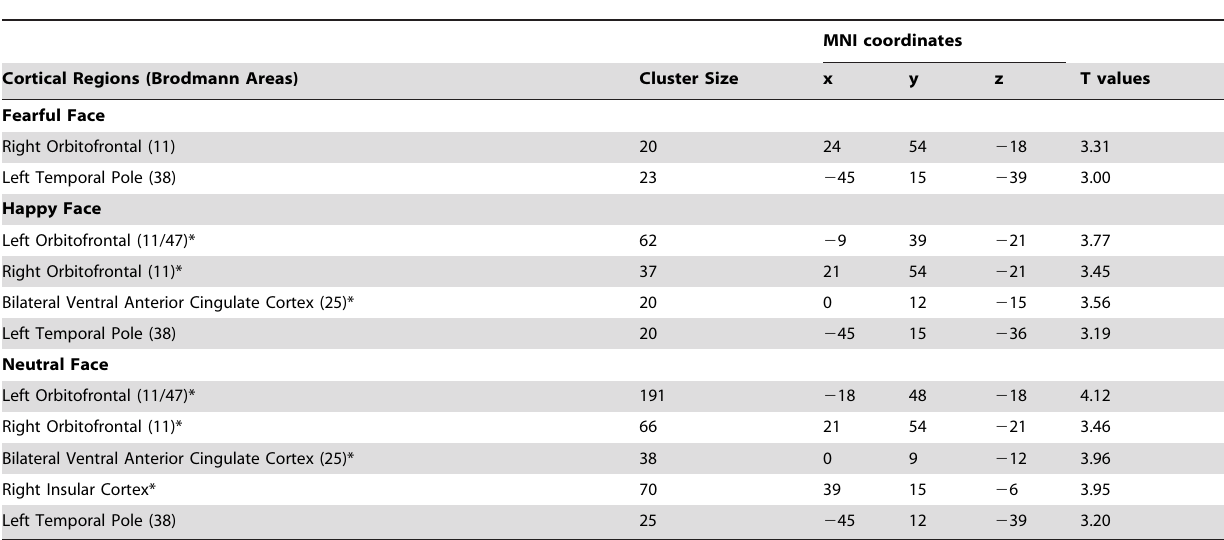
Table 1. Areas of reduced functional connectivity during emotional face processing in adolescents with bipolar disorder compared to health control